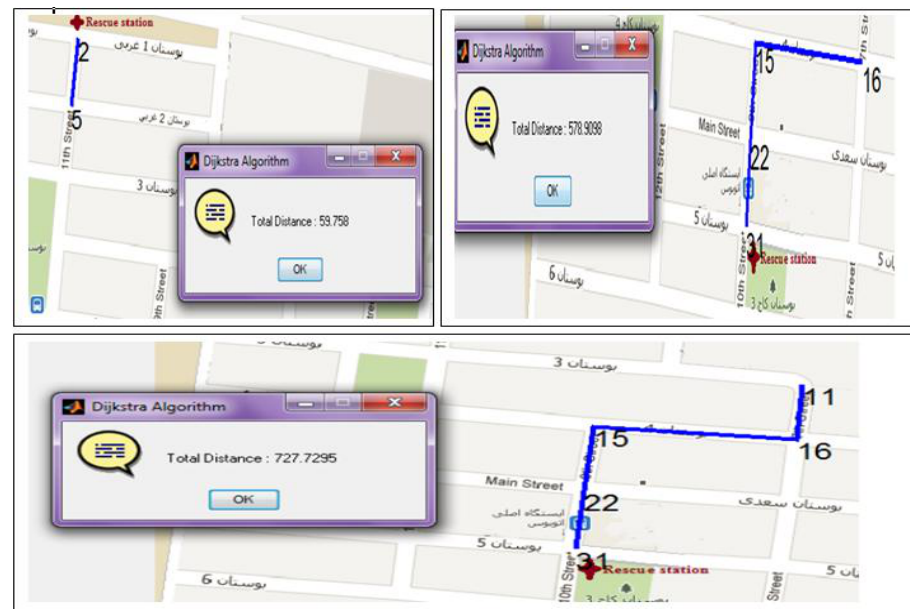
Figure 9. Program interface